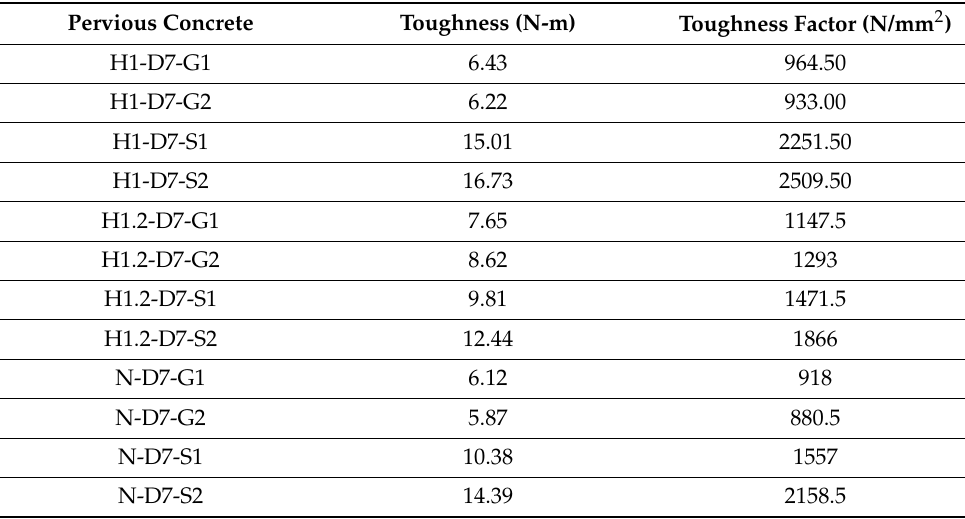
Figure 18. Flexural load and displacement diagram for H1.2 high-strength fiber pervious concrete. Table 6. Flexural toughness and toughness factor for fiber pervious concrete.